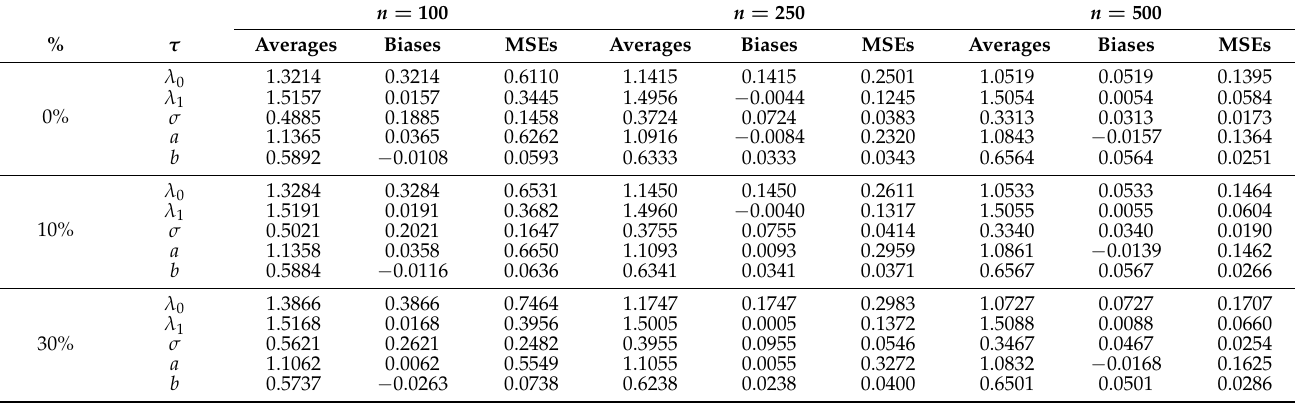
Table 2. Simulations from the WBP regression model.